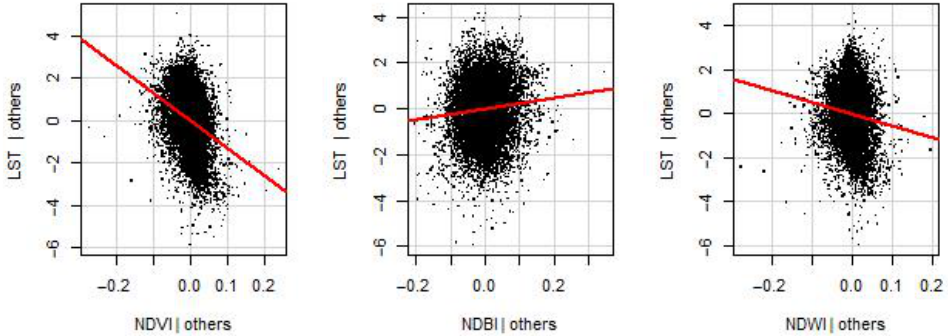
Figure 6. Partial regression plots of the multiple linear model of LST 30m defined in Equation (5).